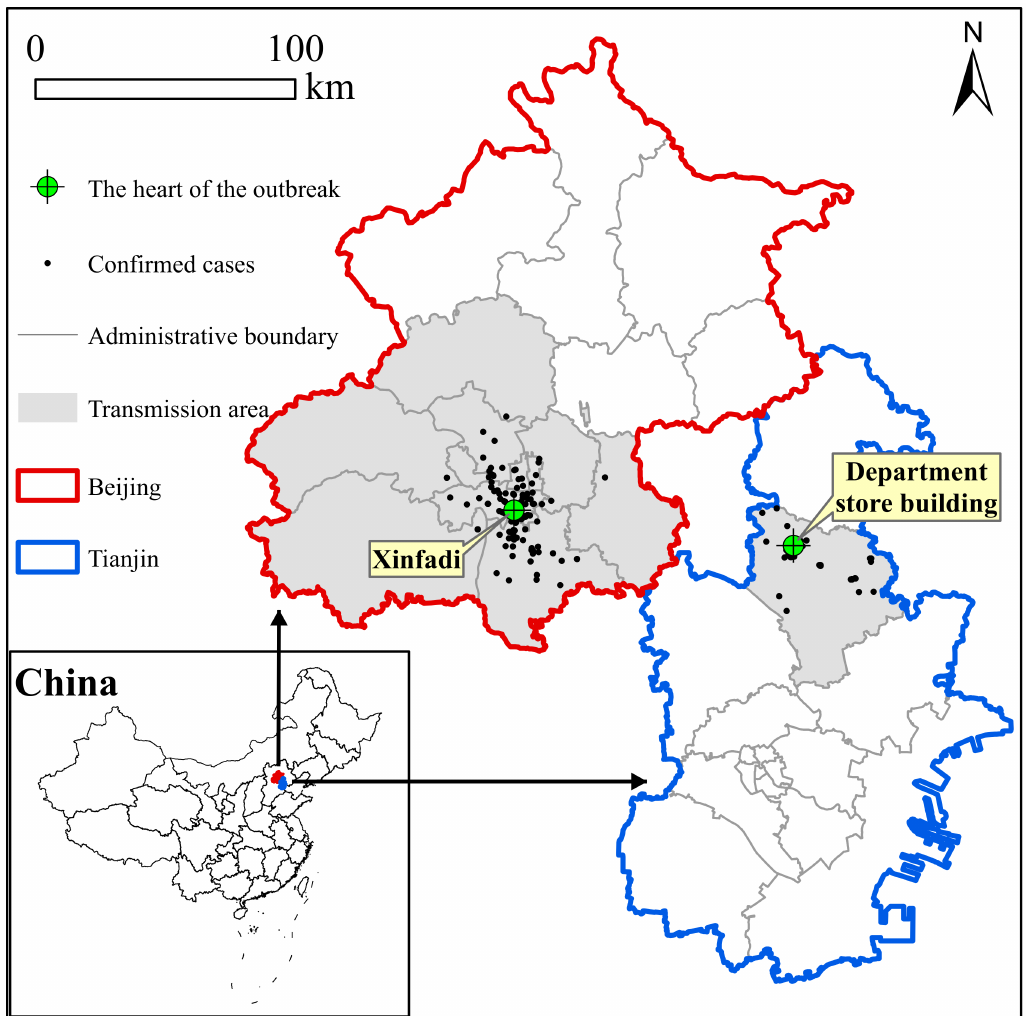
Figure 1. Location and case distribution of two outbreaks in market clusters in Tianjin and